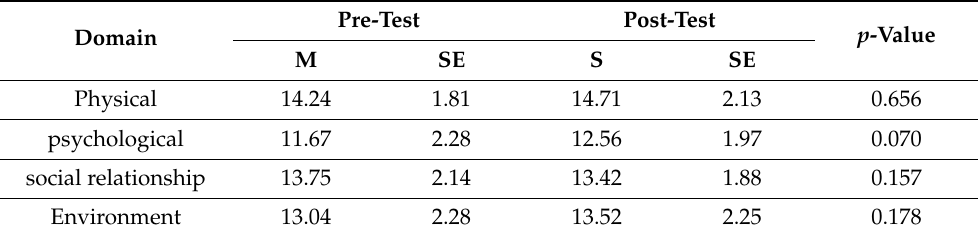
Table A2. Wilcoxon Signed Ranked Test of Domains in Pre- and